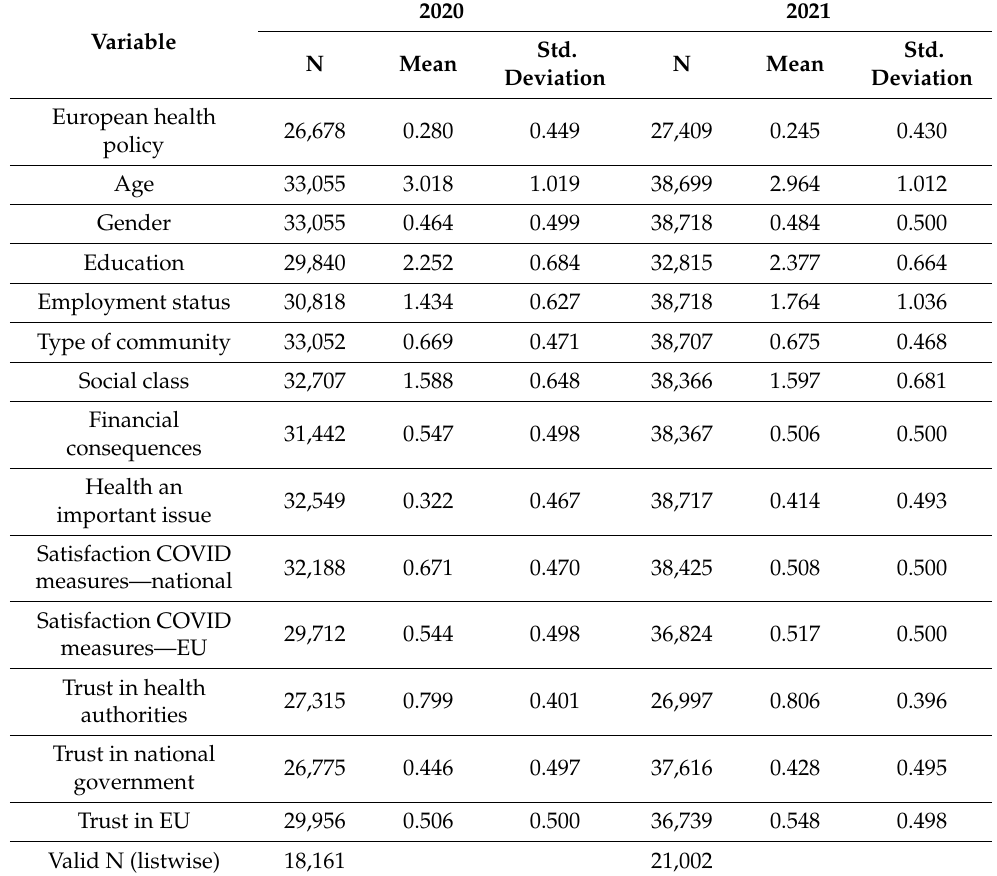
Table 2. Summary